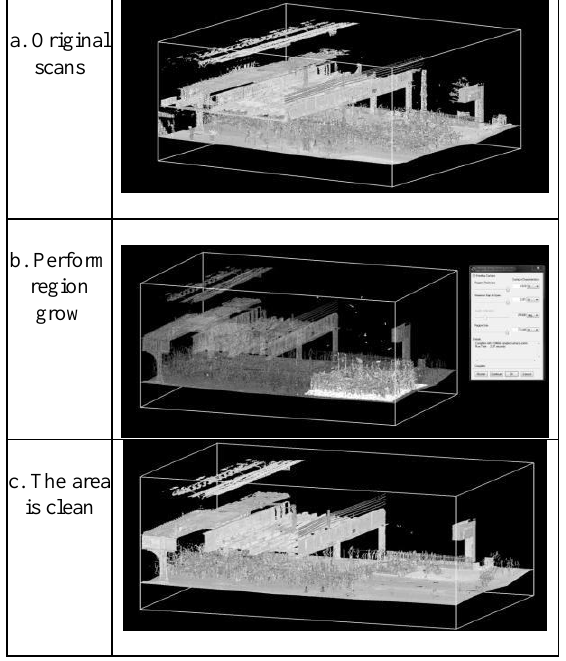
Figure 5. Region grow